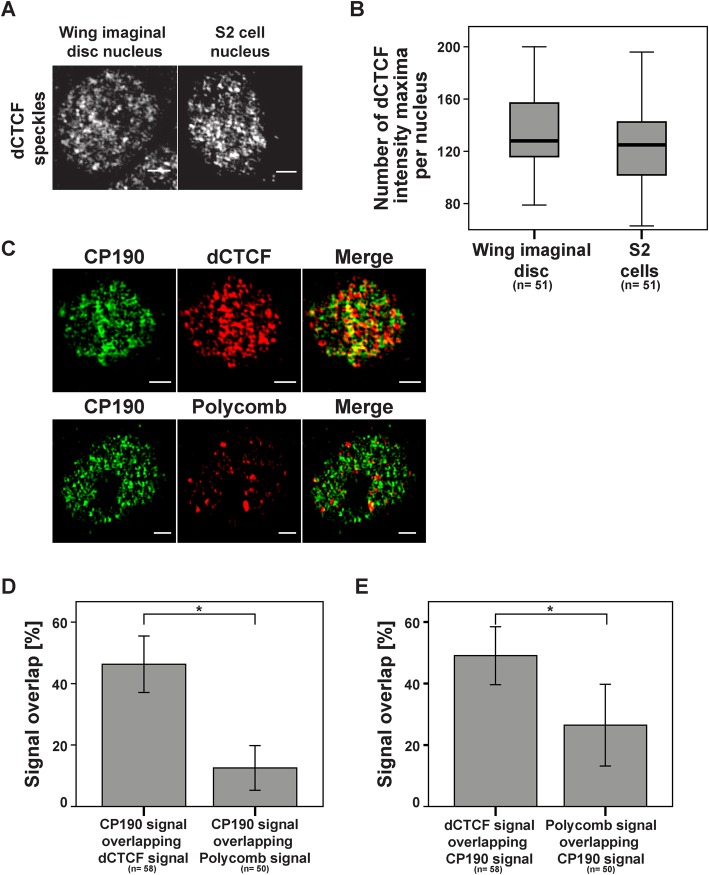
Insulator speckles are distinct from Polycomb bodies. (A) Interphase nuclei of Drosophila melanogaster wing imaginal disc and of S2 cells after staining with dCTCF antibody and SIM analysis. The speckles are distributed over the whole nucleus and size and density of speckles are similar in the two cell types. The scale bars represent 1 µm. Images illustrate z-projections of the entire nuclei. (B) Both cell types contain nearly the same number of dCTCF insulator speckles (136 speckles vs 128 speckles). (C) S2 cell nuclei are stained with antibodies against CP190 and dCTCF (top row) or against CP190 and Polycomb (bottom row) and SIM analysed. Yellow signals indicate overlapping signals in the merge case. The scale bars represent 1 µm. (D) Significant higher percentage of CP190 signals overlapping with dCTCF as compared to the overlap with Polycomb. (E) The same cells as in (D), but comparison was made between dCTCF signals overlapping with CP190 and Polycomb signals overlapping with CP190. A significantly higher incidence for the dCTCF/CP190 pair was observed. In D and E, n=total number of analysed S2 cell nuclei; error bars indicate mean±s.d.; *P≤0.05 two-tailed Mann–Whitney-U test.